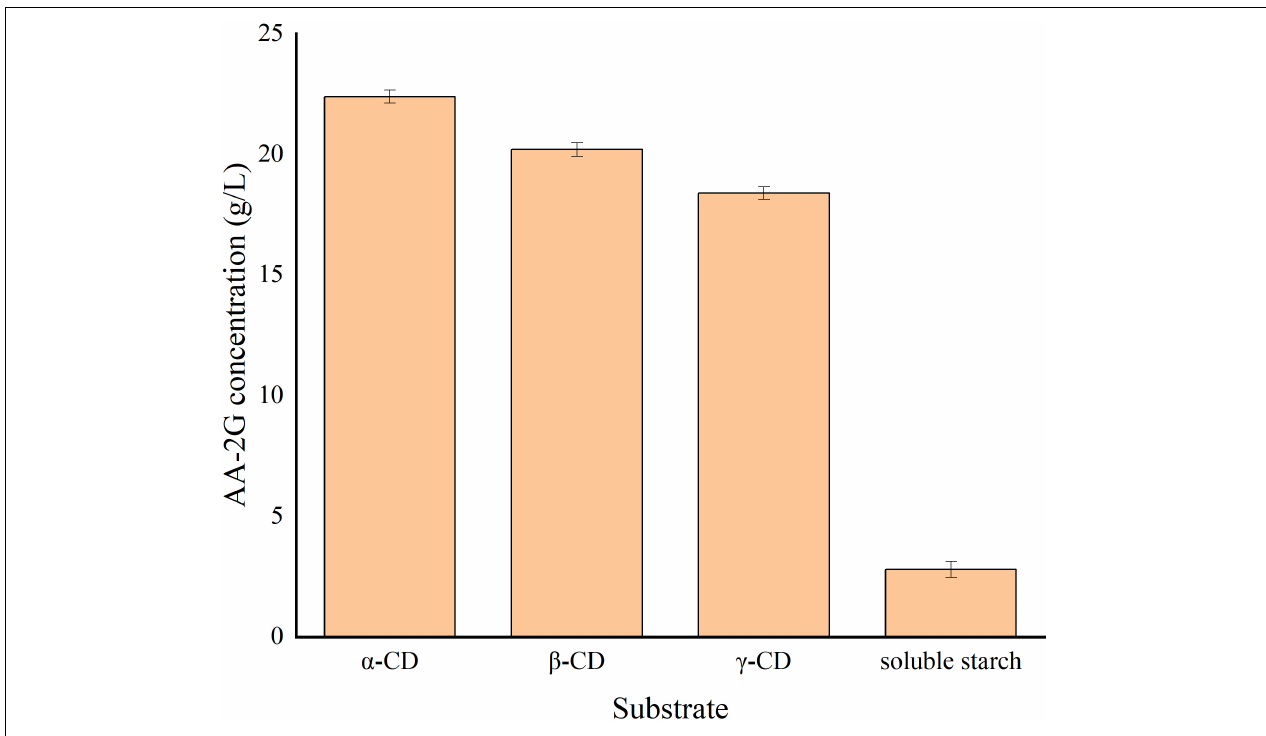
FIGURE 5 | Influence of substrate species on AA-2G synthesis.